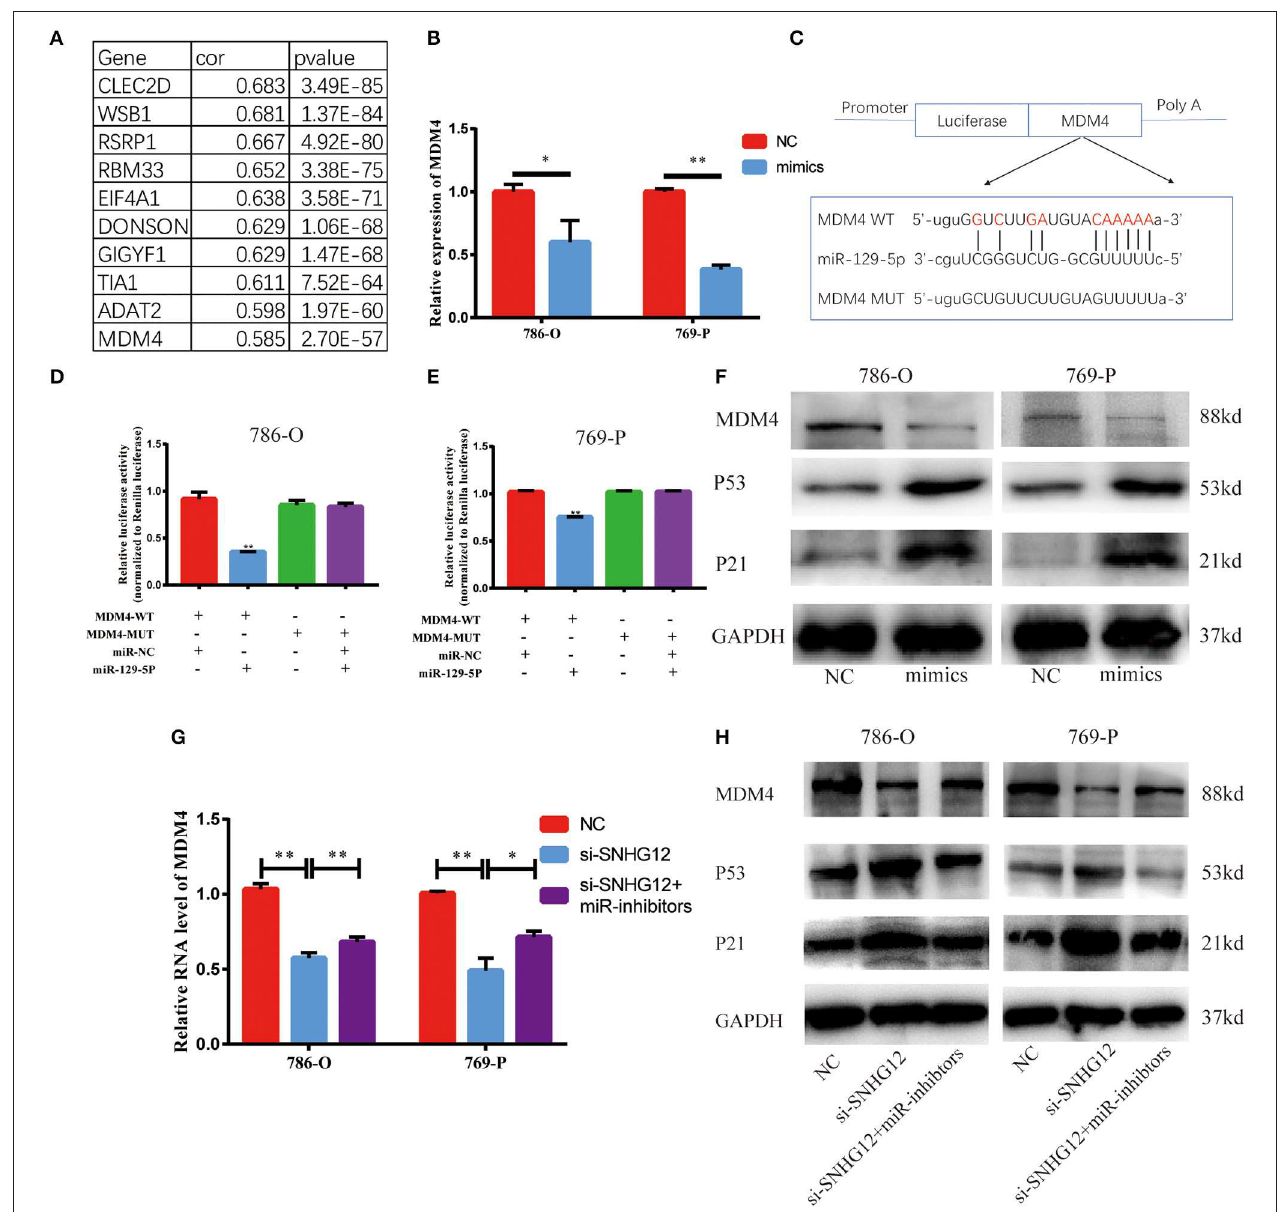
FIGURE 6 | MDM4 is a target gene of miR-129-5p and is restrained by si-SNHG12. (A) Pearson correlation analysis between SNHG12 and top 10 candidate genes predicted by StarBase v2.0. (B) QRT-PCR result of MDM4 in cells transfected with NC or miR-129-5p mimics. (C) Schematic view of miR-129-5p putative targeting site in the WT and Mut 3’ UTR of MDM4. (D,E) Luciferase activity assay in cells transfected with luciferase report plasmids containing MDM4 3’ UTR (WT or Mut), and control miRNA or miR-129-5p. (F) The western blot of MDM4 in cells transfected with NC or miR-129-5p mimics. (G) and (H) MDM4 mRNA and protein level in cells after transfecting NC, si-SNHG12 individually or co-transfected with miR-129-5p inhibitors and si-SNHG12. Values represent the mean ± SD of three independent experiments. * P < 0.05; ** P <